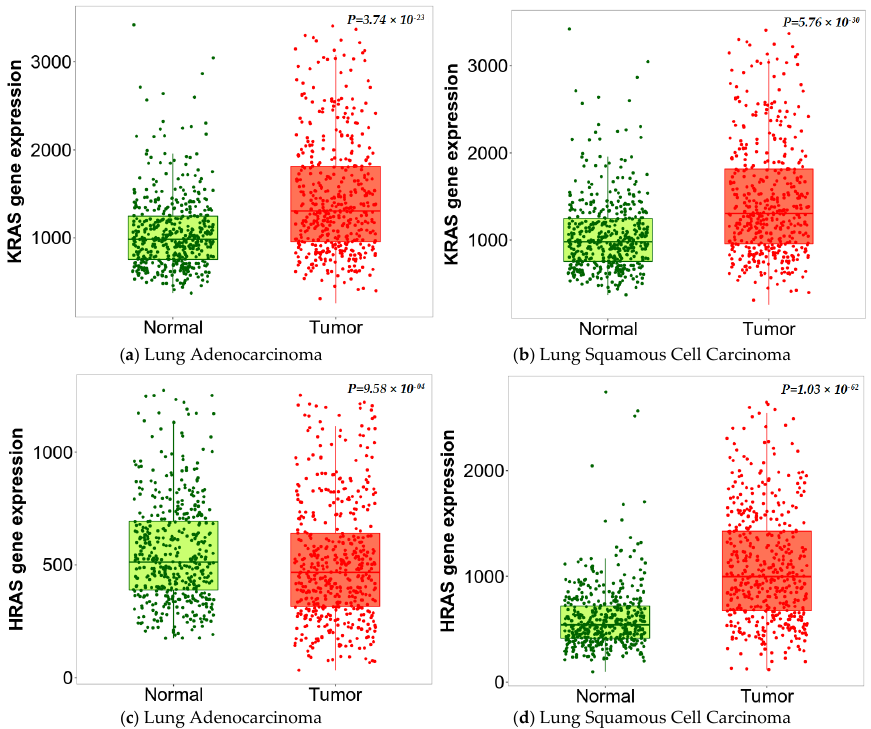
Figure 2. A comparison of KRAS and HRAS expression between normal and tumor tissues of NSCLC patients in the TNMplot database (https://www.tnmplot.com/ (accessed on 15 June 2022)). KRAS gene in LUAD and LUSC samples was significantly overexpressed in tumor compared to normal ( a , b ). HRAS mRNA expression was lower in LUAD than in normal tissue ( c ), but higher in LUSC ( d ).